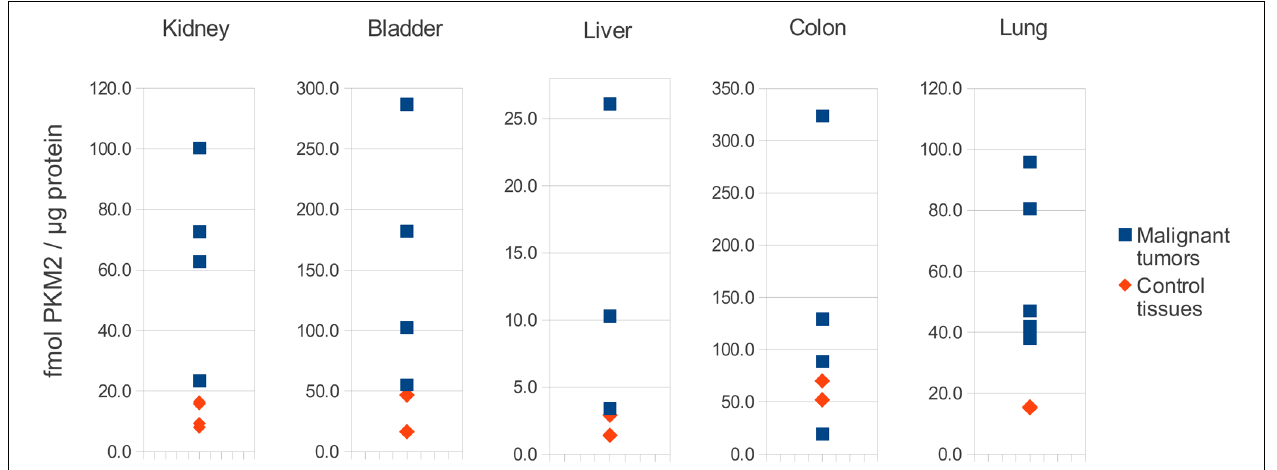
FIGURE 1 | PKM2 is up-regulated in human cancer. Illustration of the absolute concentrations of PKM2 in several cancer tissues and matched controls, as determined by liquid chromatography-multiple reaction monitoring (LC-MRM) as described in (Bluemlein etal., 2011). PKM2 levels are clearly increased in cancer biopsies compared to the controls.